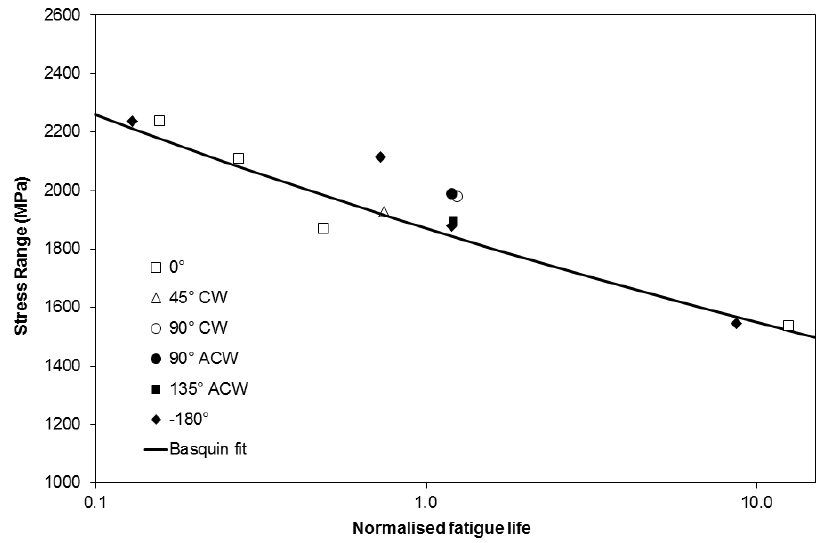
Figure 8. Basquin fit predictions of TMF